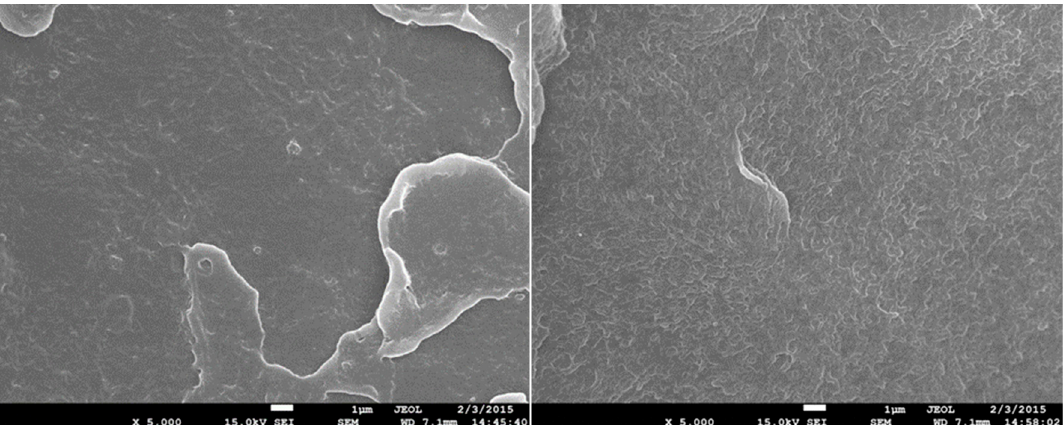
Figure 17. SEM 5000×–fracture surface of HDPE modified with radiation dose of 198 kGy after tem- Figure 17. SEM 5000 × –fracture surface of HDPE modified with radiation dose of 198 kGy after perature loading at 160 °C (left) and after five cycles of temperature loading at 160 °C (right). temperature loading at 160 ◦ C ( left ) and after five cycles of temperature loading at 160 ◦ C ( right